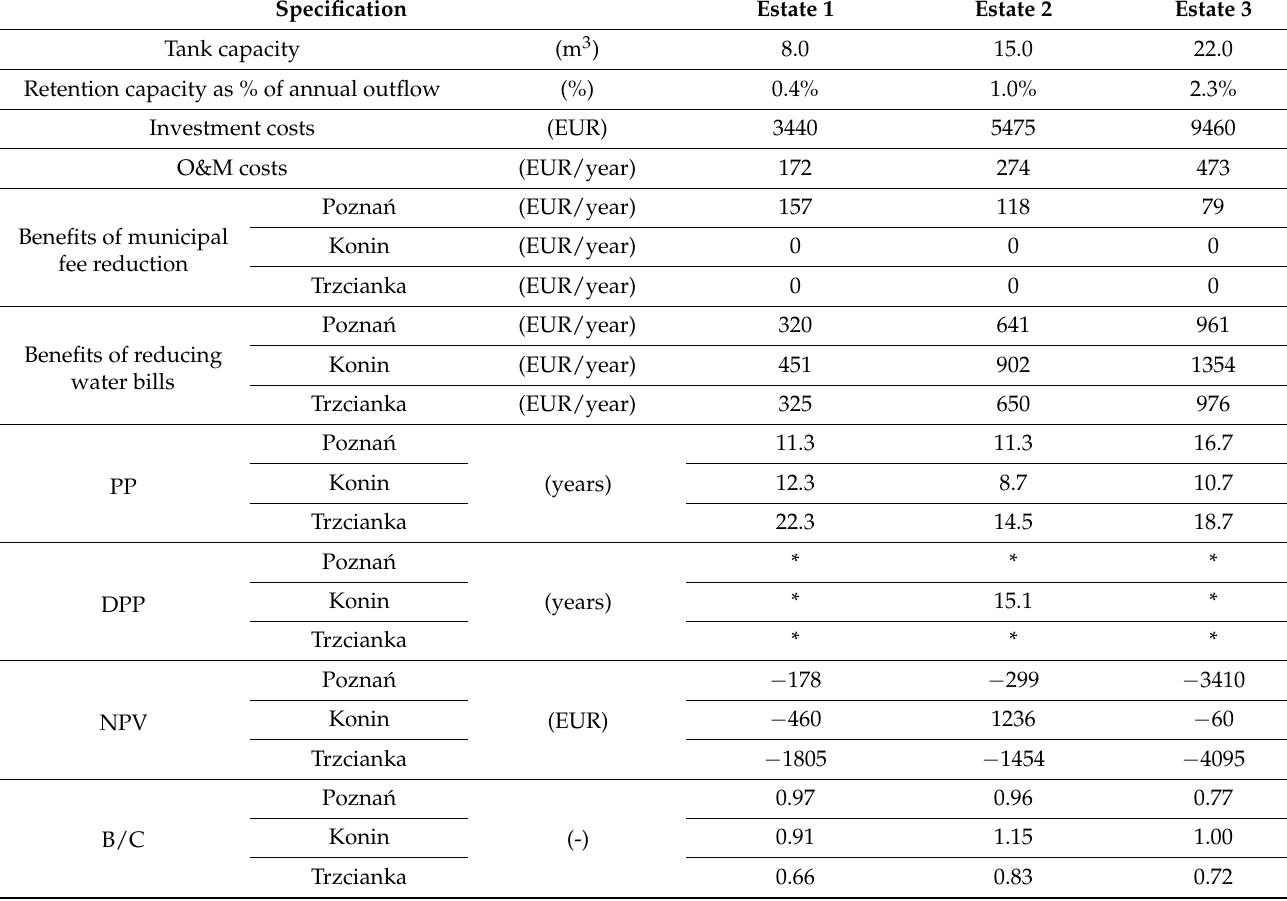
Table 18. Evaluation of the profitability of RWH